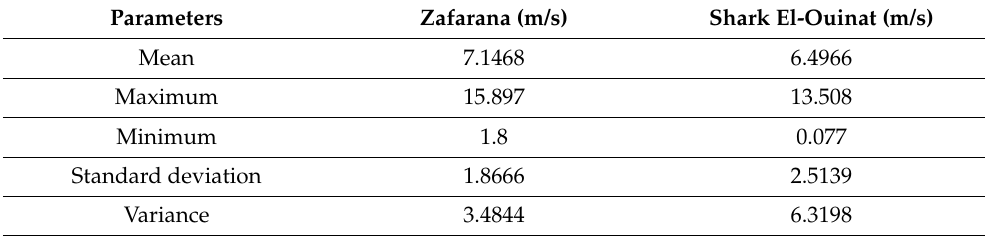
Table 2. Statistics analysis of wind speed